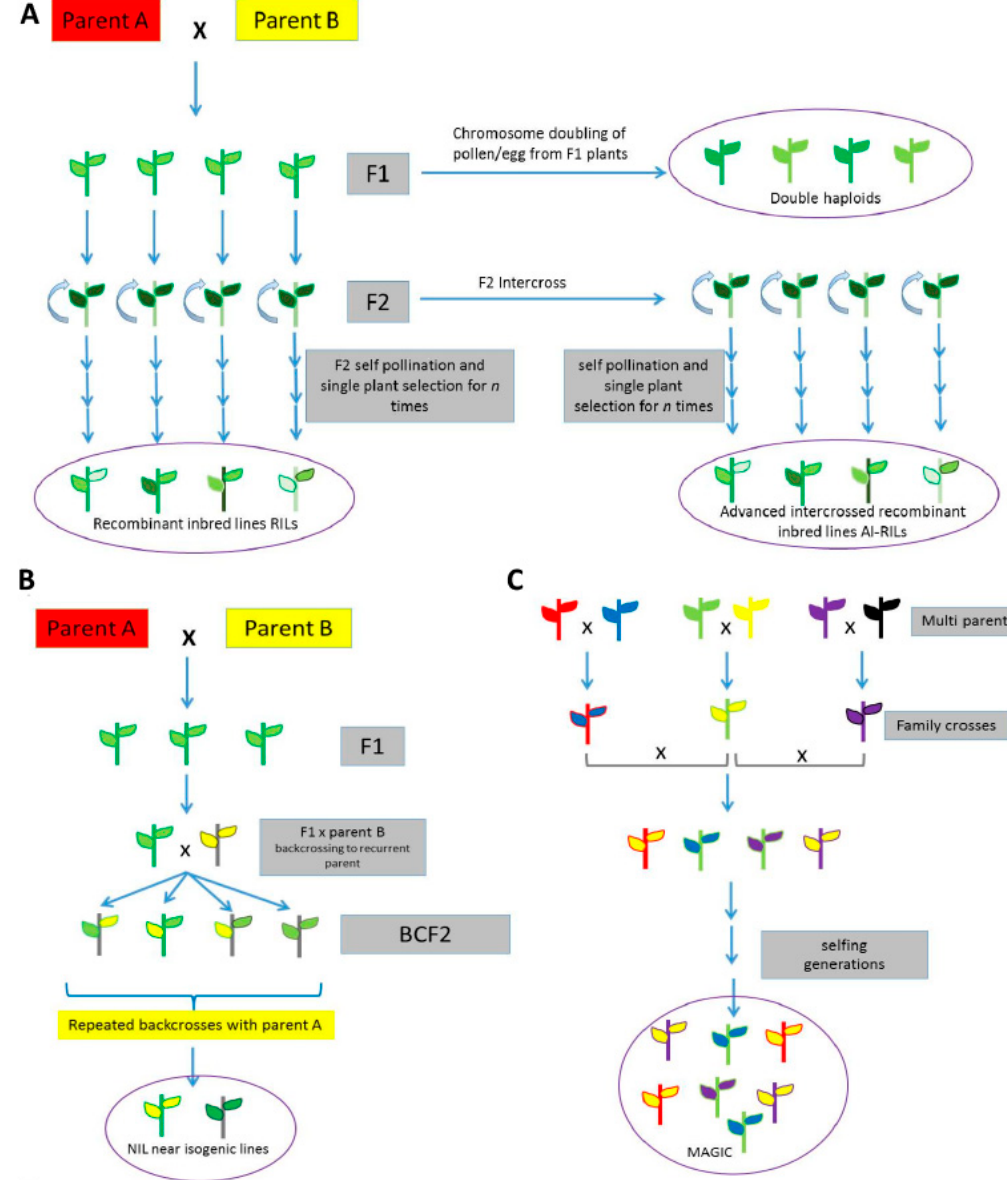
Figure 1. Population approaches commonly used in genetic studies. Marker-assisted backcrossing or gene pyramiding is the most successful method using genomics information, and are specially used in the introgression (Appendix A) of wild traits. For the identification of genomic regions/genes associated with a certain trait, three major mapping strategies are being used: QTL mapping (linkage mapping), association mapping (linkage disequilibrium mapping) and joint linkage-association mapping (Appendix A). Here are the main population approaches based on initial: bi-parental ( A , B ); or multi-parental ( C ) crosses for mapping. ( A ) F 2 : Individual F 1 plants are self-pollinated to produce an F 2 population; Doubled haploids (DH): genotypes formed when haploid cells (pollen/egg) are subjected to chromosome doubling. Recombinant inbred lines (RILs): a population generated from F 2 individual plants that are repeatedly self-pollinated n times. Advanced intercrossed recombinant inbred lines (AI-RILs): a population generated by randomly and sequentially intercrossing the F 2 lines followed by repeated self-pollinations n times; ( B ) Backcross inbred lines (BILs): repeated backcrossing (Appendix A) of F 1 lines with one of its parents; Near isogenic lines (NILs): backcrossing of F 1 with recurrent parent using lines that are identical except for differences in a few genetic loci; and ( C ) Multi-parent advanced generation inter-cross (MAGIC): a population produced by intercrossing families from multiple parents, followed by self-pollination n times.